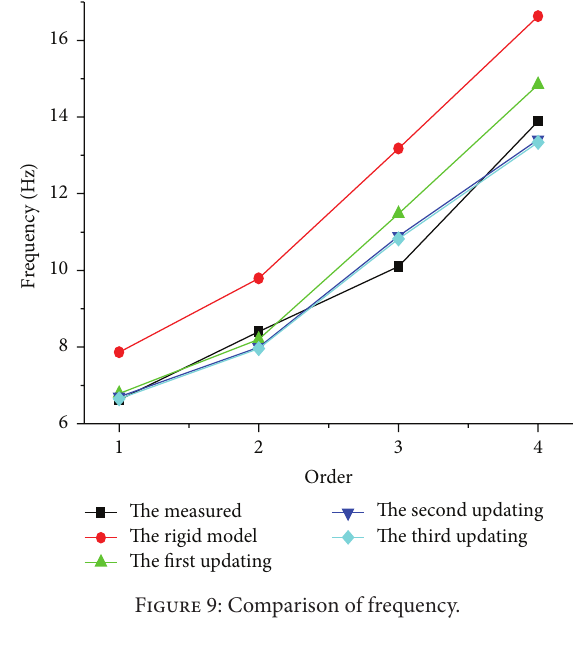
Figure 9: Comparison of frequency.